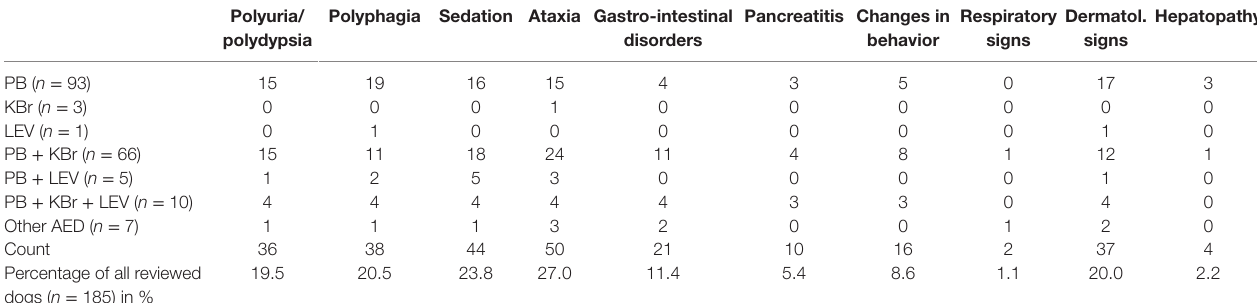
TaBle 4 | adverse events during aeD therapy ( n = 185).